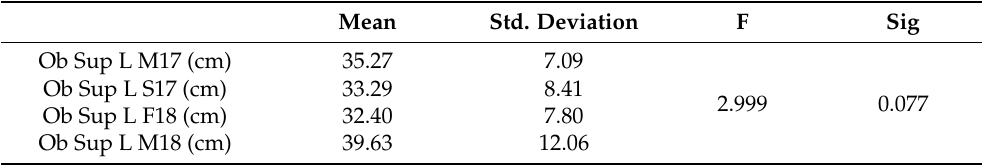
Table 6. OB values in the superolateral direction of the left arm. Mean Std. Deviation F Sig Ob Sup L M17 (cm)